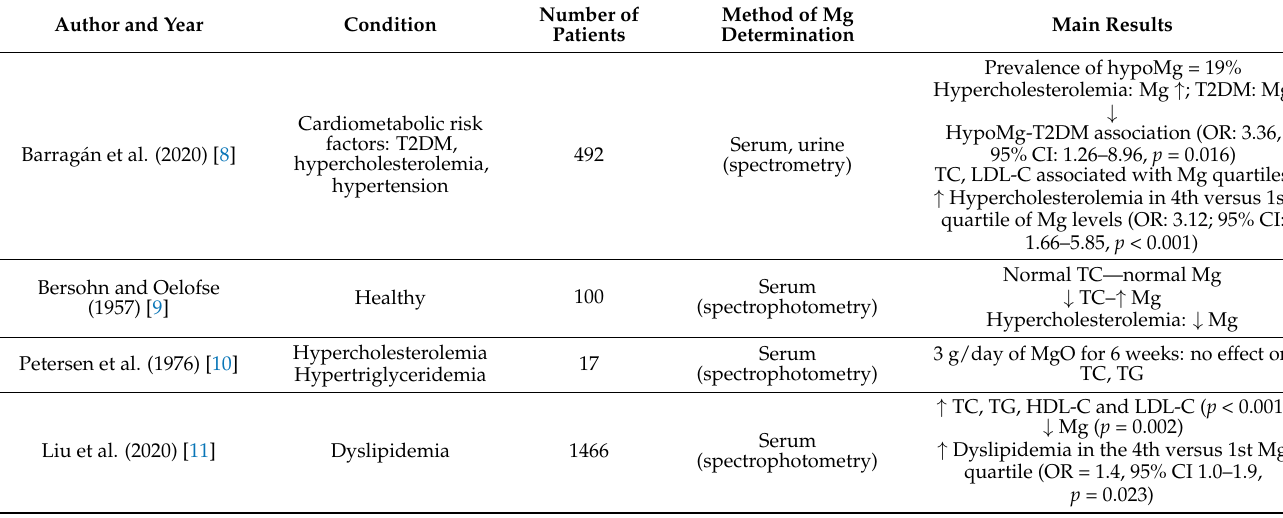
Table 1. Magnesium and serum lipids interplay in patients with a normal health status and patients diagnosed with dyslipidemia or related